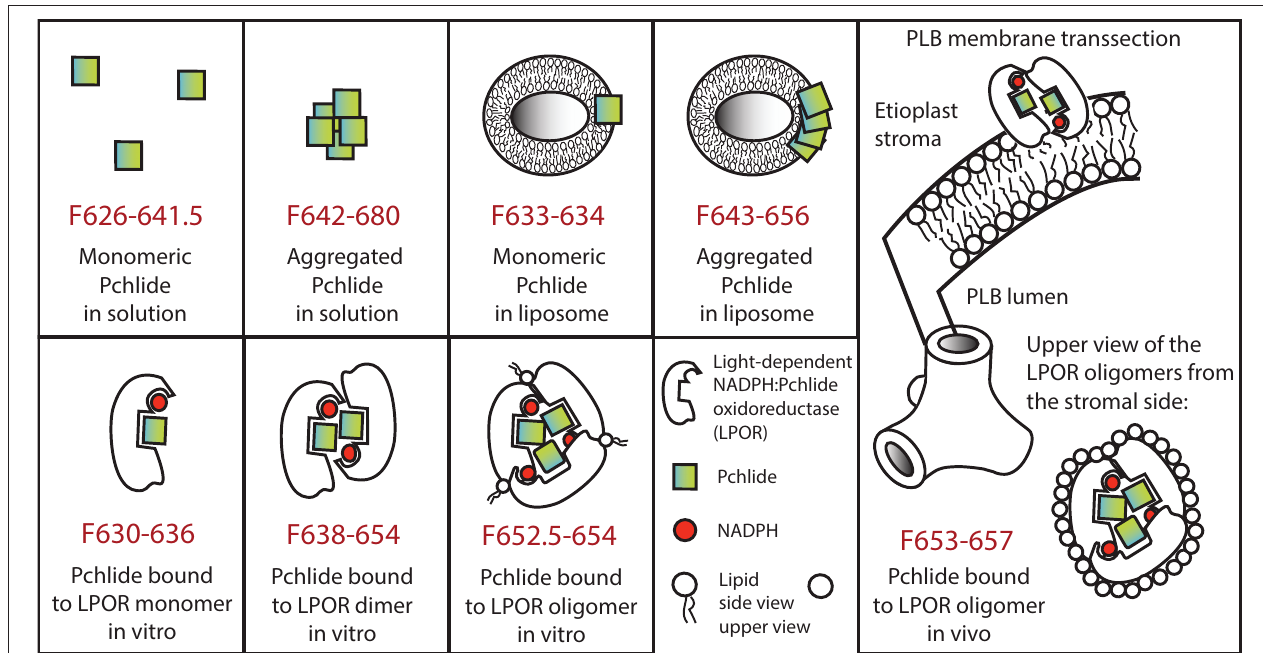
FIGURE 4 | Model representing spectral properties and molecular interactions of protochlorophyllide in various in vitro model systems as well as in vivo in case of the major photoactive protochlorophyllide form located to the prolamellar bodies. In case of oligomers for simplicity trimers are represented, although larger aggregates (e.g., tetramers and octamers) have been also reported. For further details see the text.